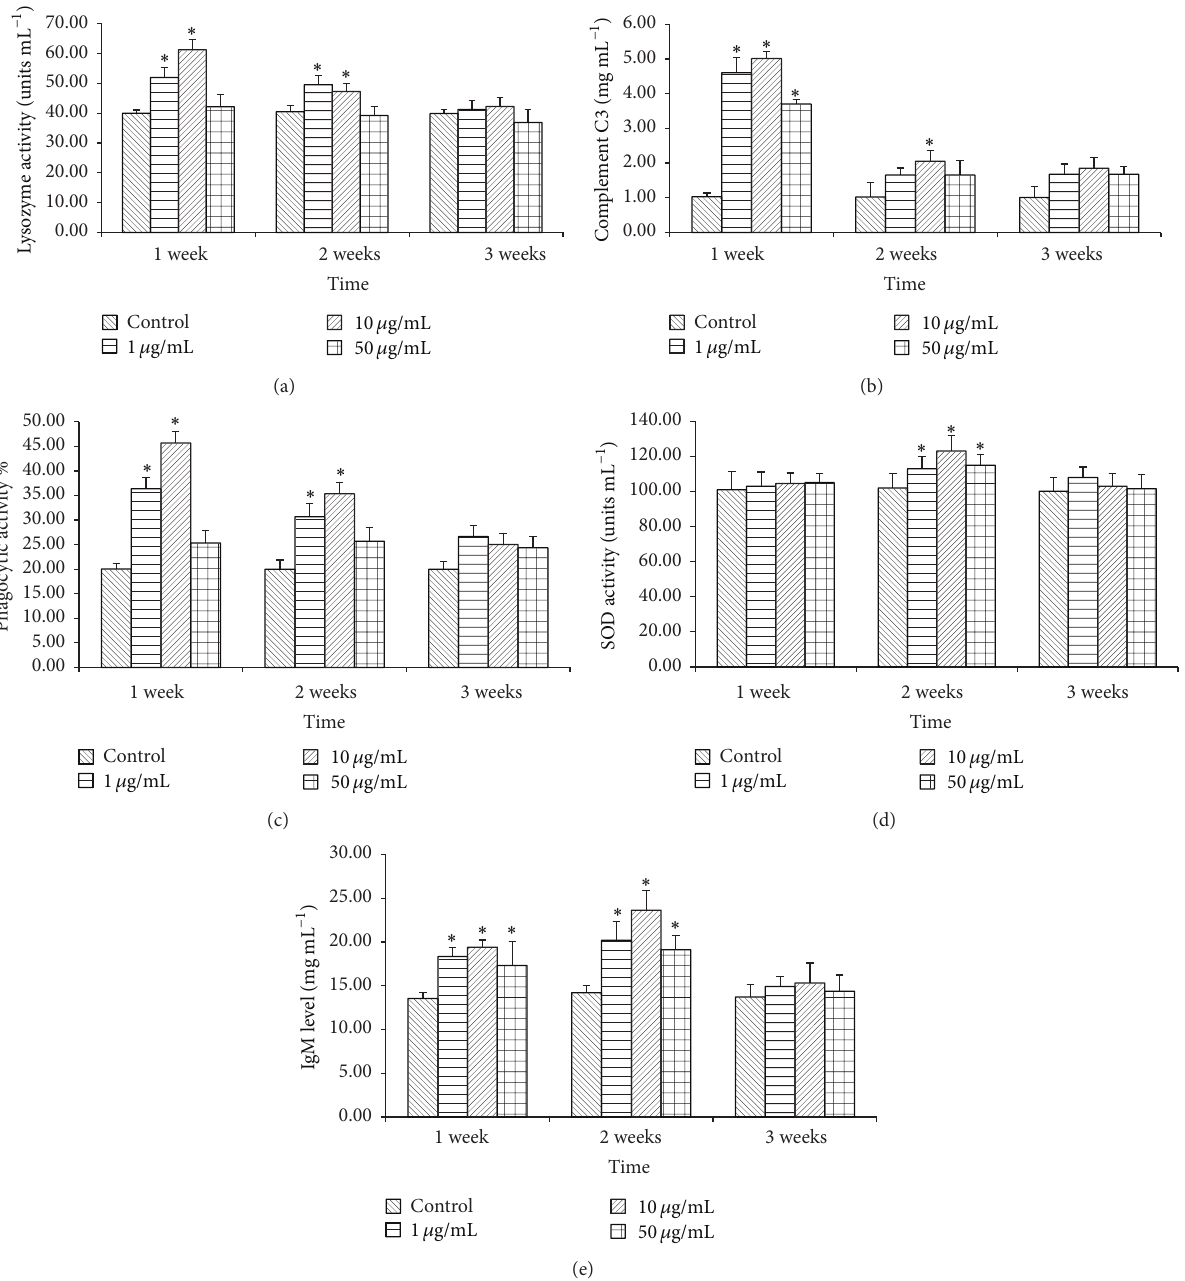
Figure 4: Effects of SA on nonspecial immune responses in C. idella immunised (i.p) with SA at different time points. (a) Lysozyme activity; (b) complement C3 level; (c) phagocytic activity; (d) SOD activity; (e) IgM level. Bars represent the mean ± S.E.M ( 𝑛 = 9 ). A significant difference compared to control on the same sampling week is indicated by an asterisk ( ∗